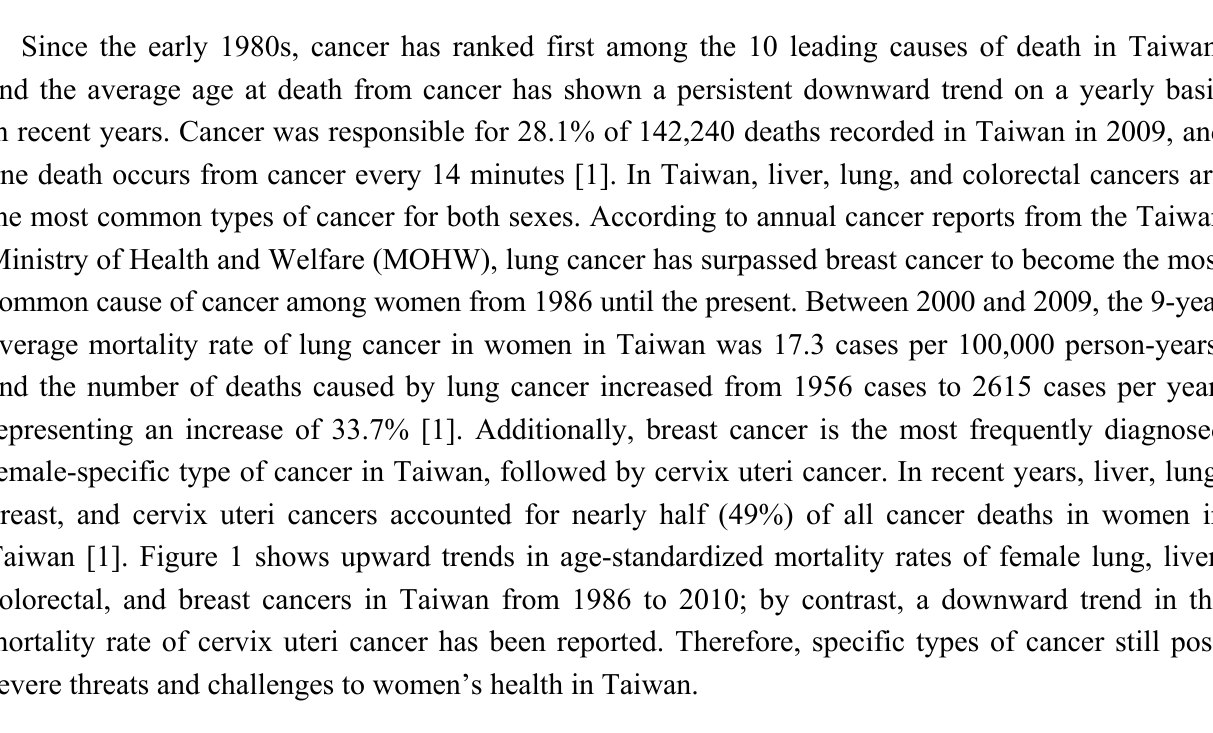
Figure 1. Secular trends in age-standardized mortality rates of lung, liver, colorectal, breast, and cervix uteri cancers for females in Taiwan,